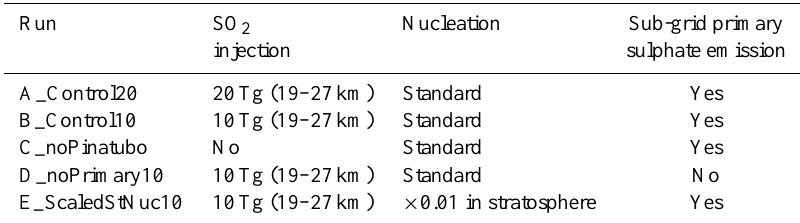
Table 2. Microphysical parameter settings used in model